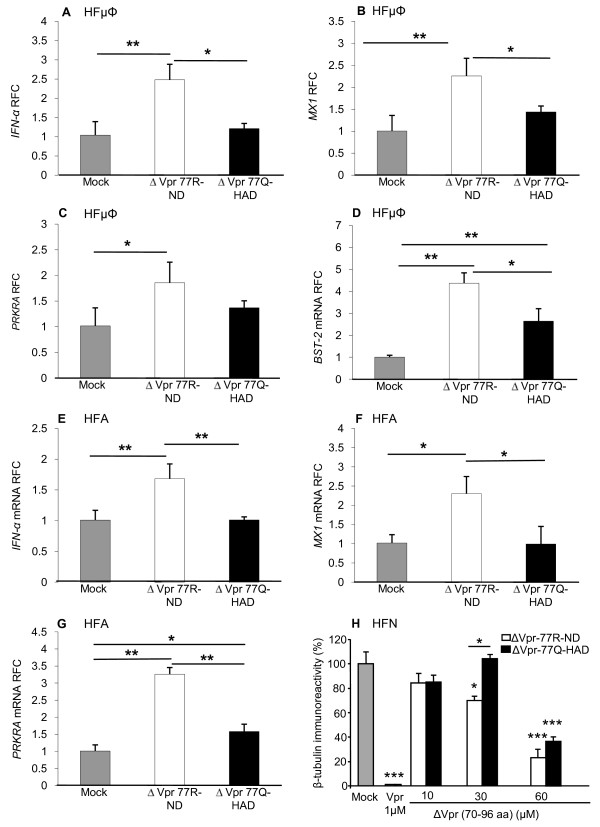
Vpr peptides (aa 70-96) exert neuroimmune and neurotoxic effects. Exposure of ΔVpr77Q-HAD (5.0 μM) or ΔVpr77R-ND (5.0 μM) to human microglia resulted in ΔVpr77R-ND-mediated induction of (A) IFN-α, (B) MX1, (C) PRKRA and (D) BST-2 transcripts. Similarly, human astrocytes exposed to the same peptides showed induction of (E) IFN-α, (F) MX1 and (G) PRKRA expression. (H) Exposure of ΔVpr77R-ND to human neurons caused a concentration-dependent (10.0-60.0 μM) reduction in β-tubulin immunoreactivity while ΔVpr77Q-HAD showed less neurotoxicity. Full length Vpr (1.0 μM) was also highly neurotoxic. Experiments were carried out in triplicate at least two times (A-D, Dunnett test, relative to control; *p < 0.05, **p < 0.01).